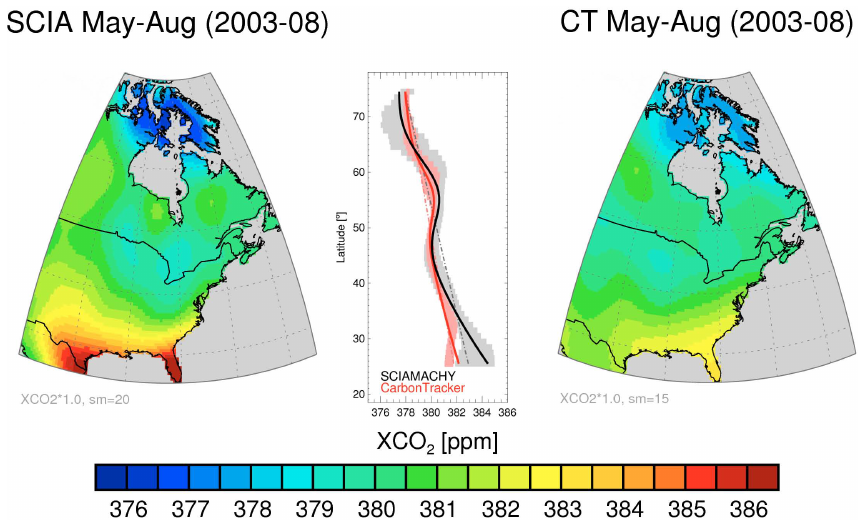
Fig. 10. Seasonally averaged (May–August) SCIAMACHY (left) and CarbonTracker (right) XCO 2 during 2003–2008 over North America demonstrating that there is also a complex curved north-south gradient in the atmosphere during the growing season. The corresponding latitudinal gradients derived by fitting linear combinations of a Gaussian and a quadratic polynomial are shown in the middle panel as solid black and red lines together with the standard deviations (shaded regions) of the zonal XCO 2 averages (0.5 ◦ bins). The dash-dotted pale straight lines are linear fits of the gradients.